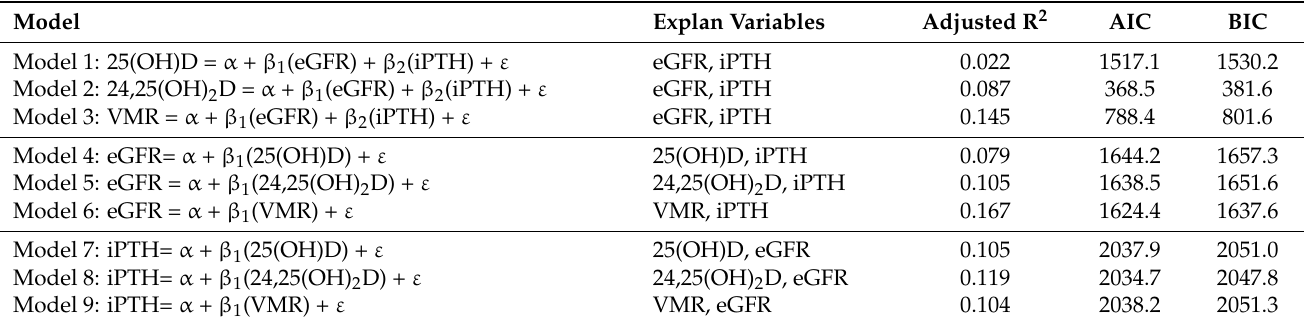
Figure 3. Change in vitamin D biomarkers and intact parathyroid hormone according to CKD stage. Abbreviations: CKD, Chronic Kidney Disease; iPTH, intact parathyroid hormone; VMR, vitamin D metabolites ratio; 25(OH)D, 25-hydroxy vitamin D; 24,25(OH) 2 D, 24,25-dihydroxy vitamin D. Nine multiple regression analysis models were created to explain the relationships between the three vitamin D biomarkers and the eGFR or iPTH. The fit of each model was compared using the adjusted R 2 , the Akaike information criterion, and the Bayesian information criterion. In models using the eGFR as a dependent variable (models 4–6), model 6, which explained the eGFR using the VMR, had the best fit. Of the three vitamin D biomarkers, the VMR was the most strongly associated with the eGFR. In the models using iPTH as a dependent variable (models 7–9), model 8, which explained iPTH using 24,25(OH) 2 D, had the best fit. Of the three vitamin D biomarkers, 24,25(OH) 2 D was most strongly associated with the iPTH level (Table 3). Table 3. Model fitness of vitamin D biomarkers models.